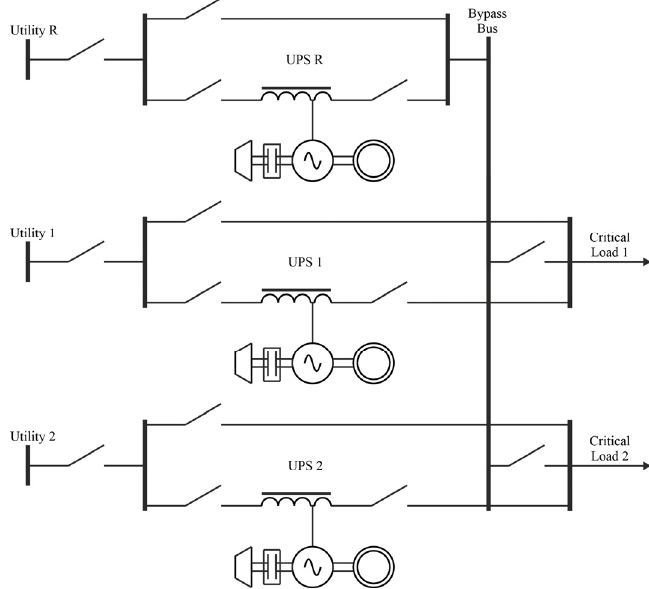
Figure 5. Configuration of Isolated Redundant.